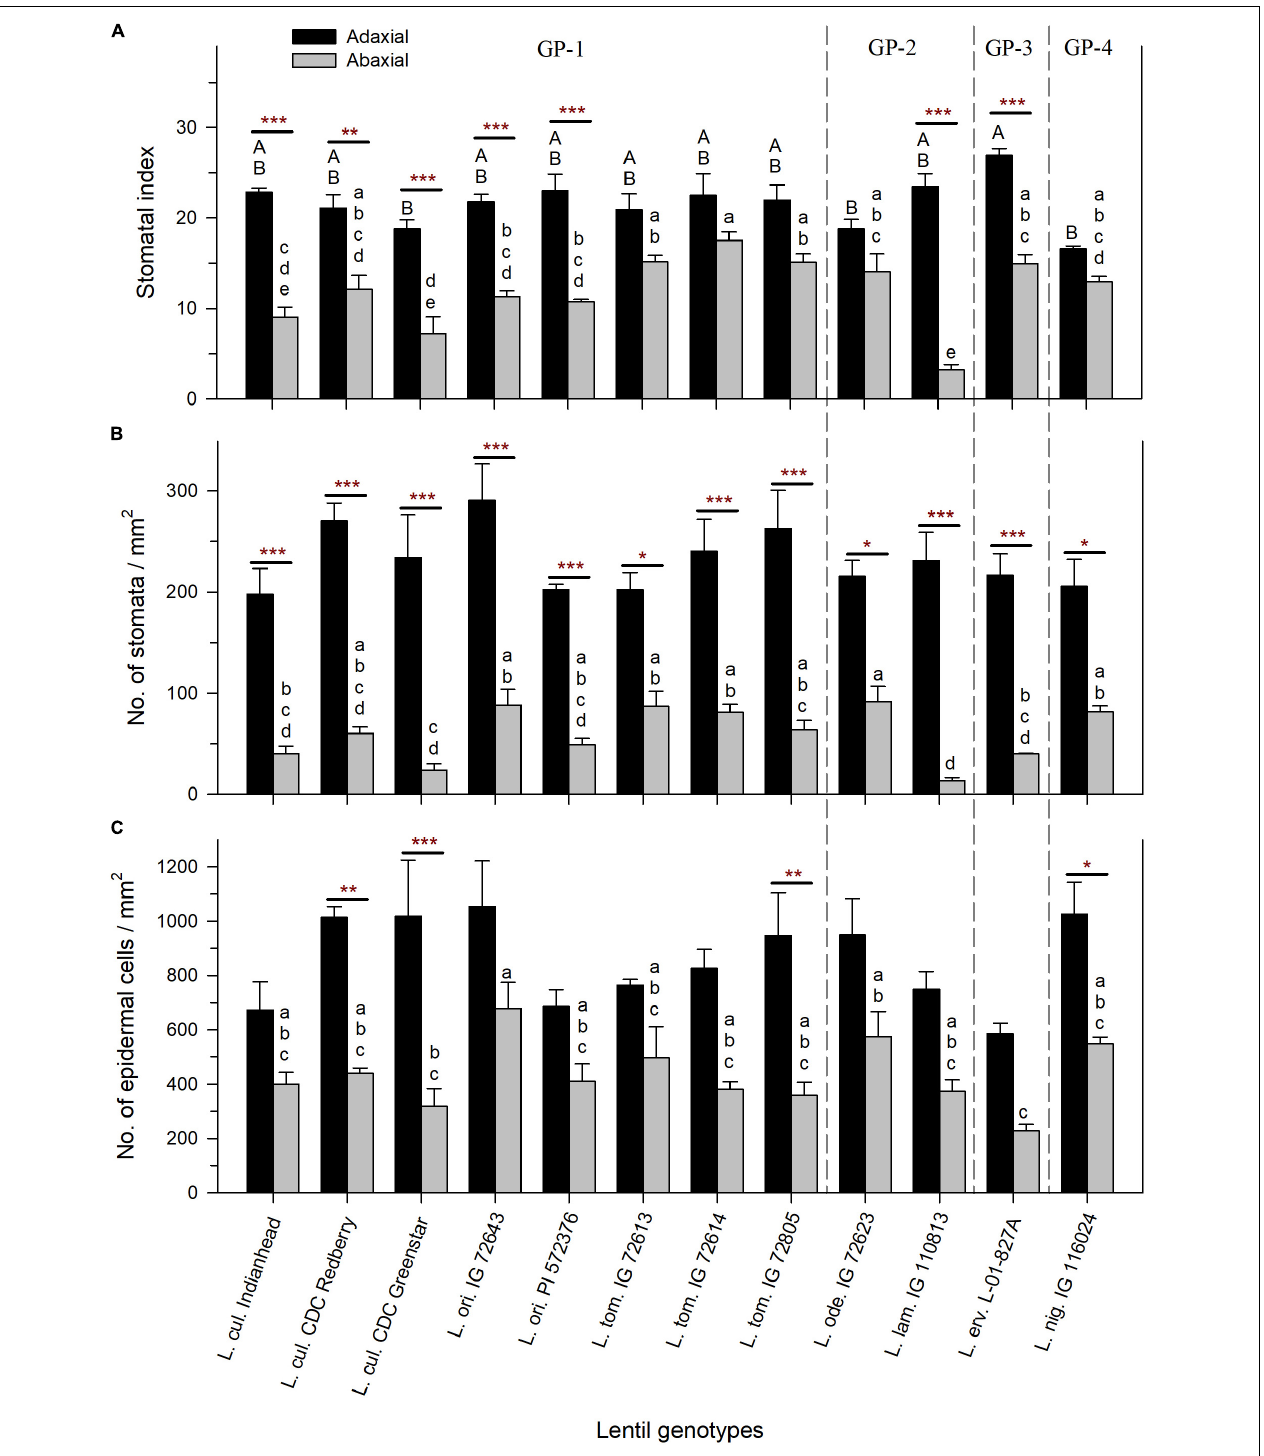
FIGURE 4 | Stomatal index expressed as % (A) , stomatal density expressed as the number of stomatal pores per mm 2 (B) , and epidermal cell density expressed as the number of epidermal cells per mm 2 (C) on the adaxial and abaxial leaflet surface of cultivated and wild lentil genotypes. Stars represent the statistical difference between adaxial and abaxial surfaces of the same genotype based on t -test (Significance: * p < 0.05; ** p < 0.01; *** p < 0.001). No stars imply no significant difference. Uppercase and lowercase letters show significant differences between the adaxial and abaxial surfaces, respectively, across all genotypes at alpha equals 5%. Absence of letters implies no significant difference. GP-1, GP-2, and GP-3 denote the genotypes from the primary, secondary, and tertiary gene pools, respectively (Wong et al., 2015).